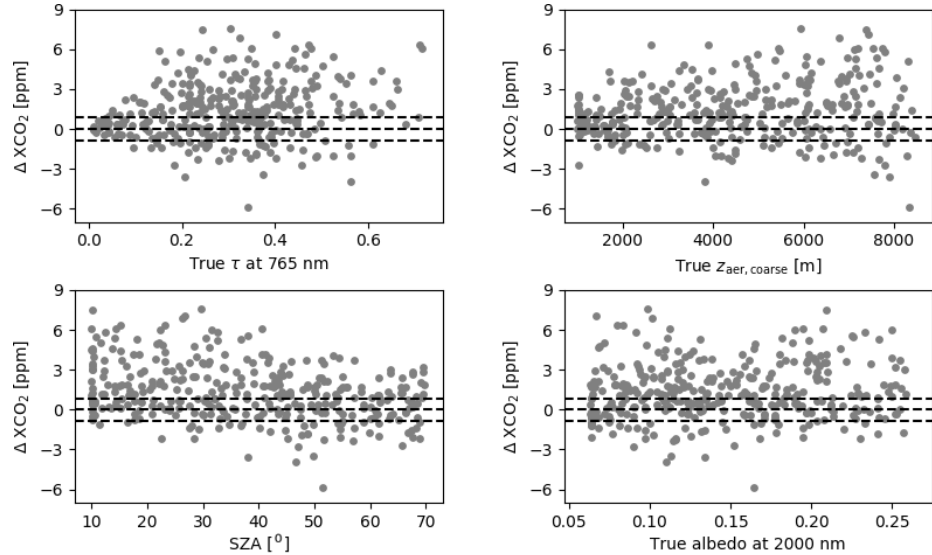
Figure 1. Residual XCO 2 from the converged retrievals using spectrometer measurements only, shown as a function of total aerosol optical depth τ , coarse-mode aerosol height, SZA, and albedo. The input spectra are generated according to the ensemble of synthetic scenes (Sect. 4). The three dashed horizontal lines indicate (cid:49) XCO 2 at − 0 . 86, 0, and